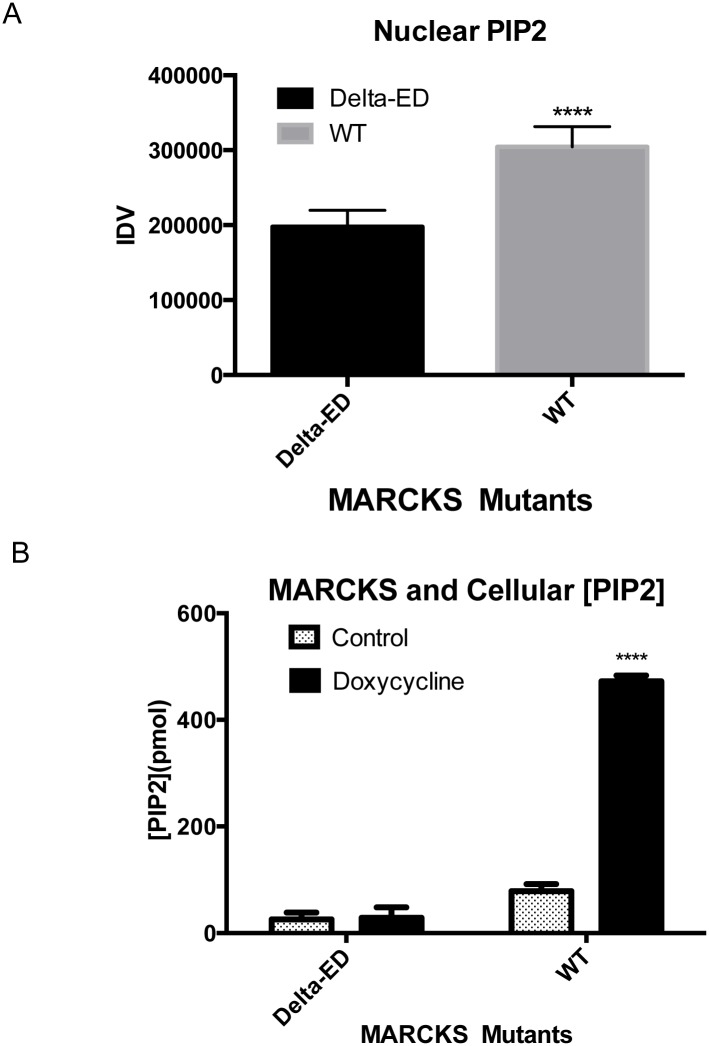
Changes in PIP2 in ED-deleted MARCKS expressing glioma cells.
A) Nuclear PIP2 immunofluorescence staining was quantified in the U87 WT- and ΔED- MARCKS expressing cells as described in Materials and Methods. Briefly, DAPI-defined nuclear regions of interest were generated and an integrated density value (IDV) was calculated for each nucleus. The mean IDV and standard error are shown (t-test p = 0.0043). B) Total levels of PIP2 were quantified for U87 WT- and ΔED- MARCKS expressing cells with or without doxycycline treatment using a PI(4,5)P2 Mass ELISA KIT. Mean PIP2 concentrations with standard errors are shown (t-test p< 0.0001).